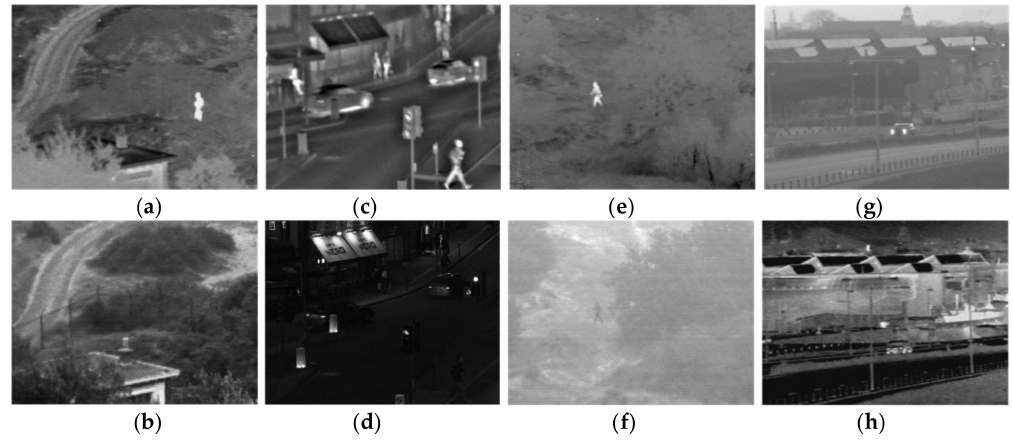
Figure 4. Images for experiment: ( a , b ) the first set of experimental images; ( c , d ) the second set of experimental images; ( e , f ) the third set of experimental images; and ( g , h ) the fourth set of experimental images.